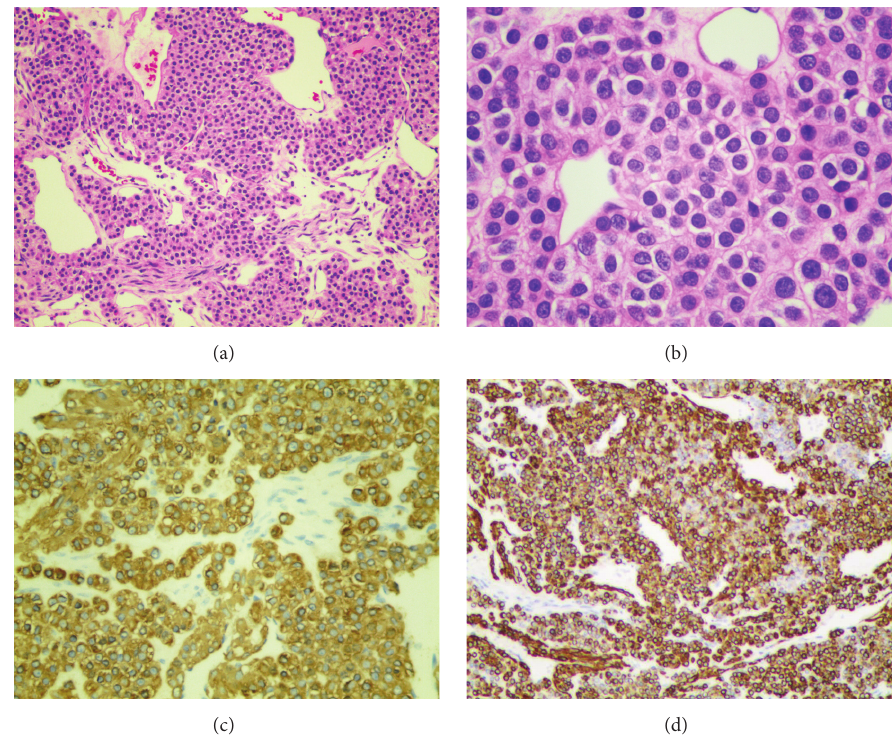
Figure 3: Histopathology showed that the tumor cells exhibited a sheet-like growth pattern with abundant eosinophilic cytoplasm and round nuclei. (a) Original magnification, 100x. (b) Original magnification, 400x. Immunohistochemistry for (c) SMA and (d) h-cald was